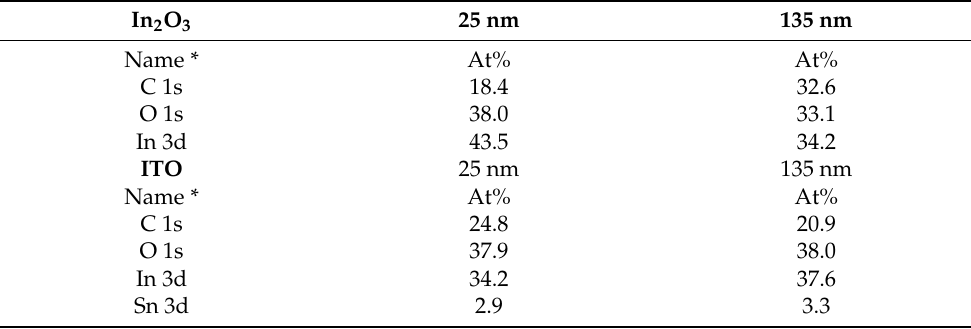
Table 5. The results of survey spectra of In 2 O 3 and ITO sample surfaces